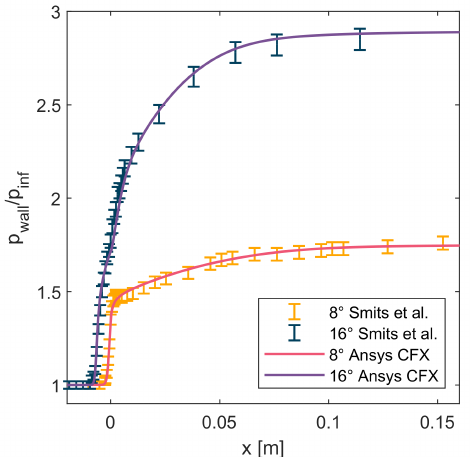
Figure 7. Comparison between the experimental solution [28] and Ansys CFX for the compression corner problem at 8° and 16° ramp